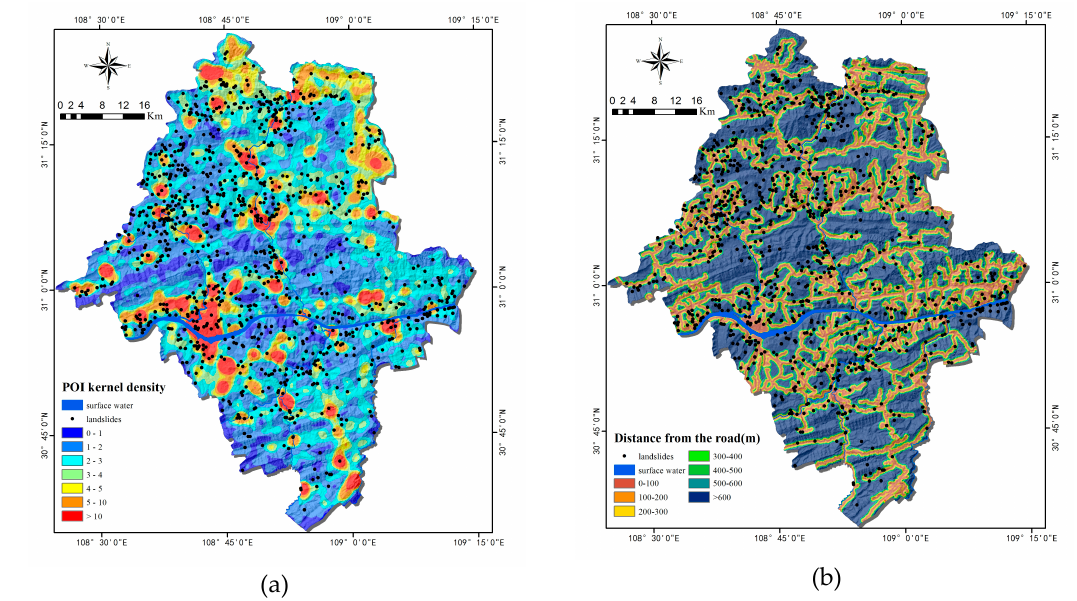
Figure 10. Thematic maps of human engineering activities: ( a ) Point of interest (POI) kernel density; ( b ) Distance from the road.